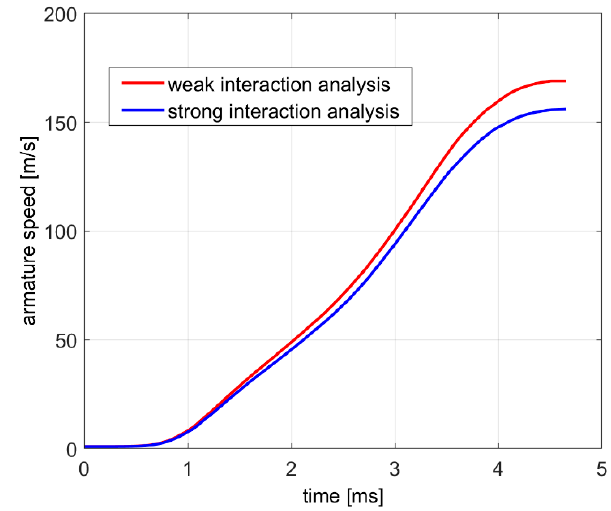
Figure 14. Comparison of the armature speed during the launch as predicted by weak and the strong interaction analysis.